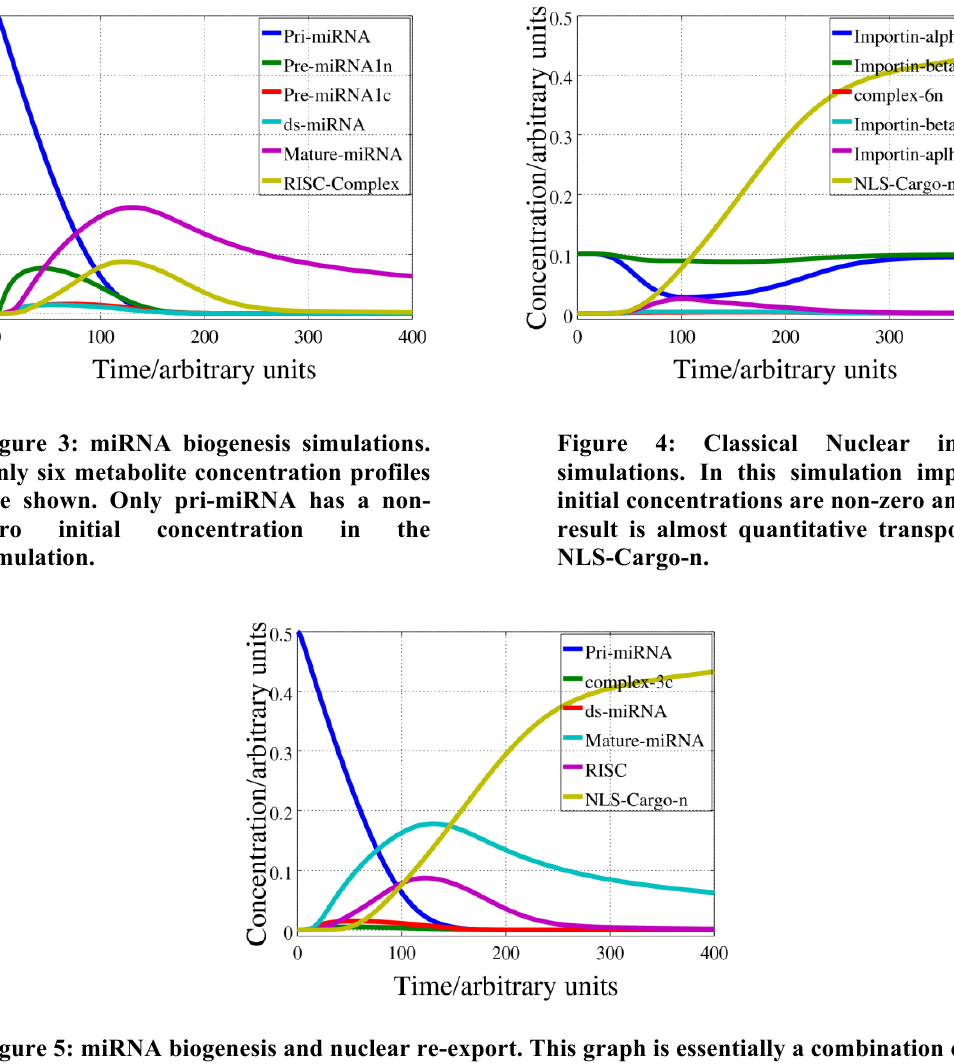
Figure 5: miRNA biogenesis and nuclear re-export. This graph is essentially a combination of the previous two graphs. The pri-miRNA (dark blue curve) is processed and mostly transferred as NLS-Cargo-n (across the nuclear membrane to the other